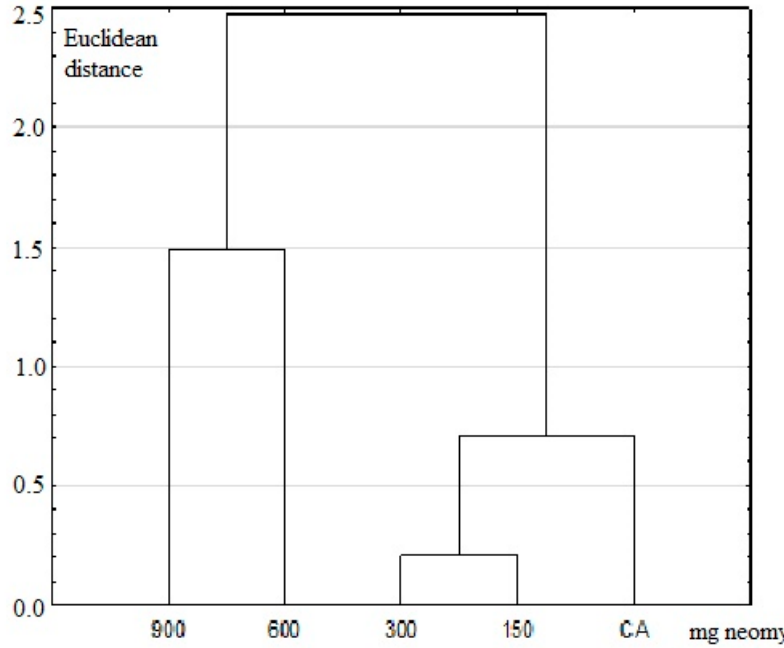
Figure 4. Graph of principal-component analysis for larva anal papillae.